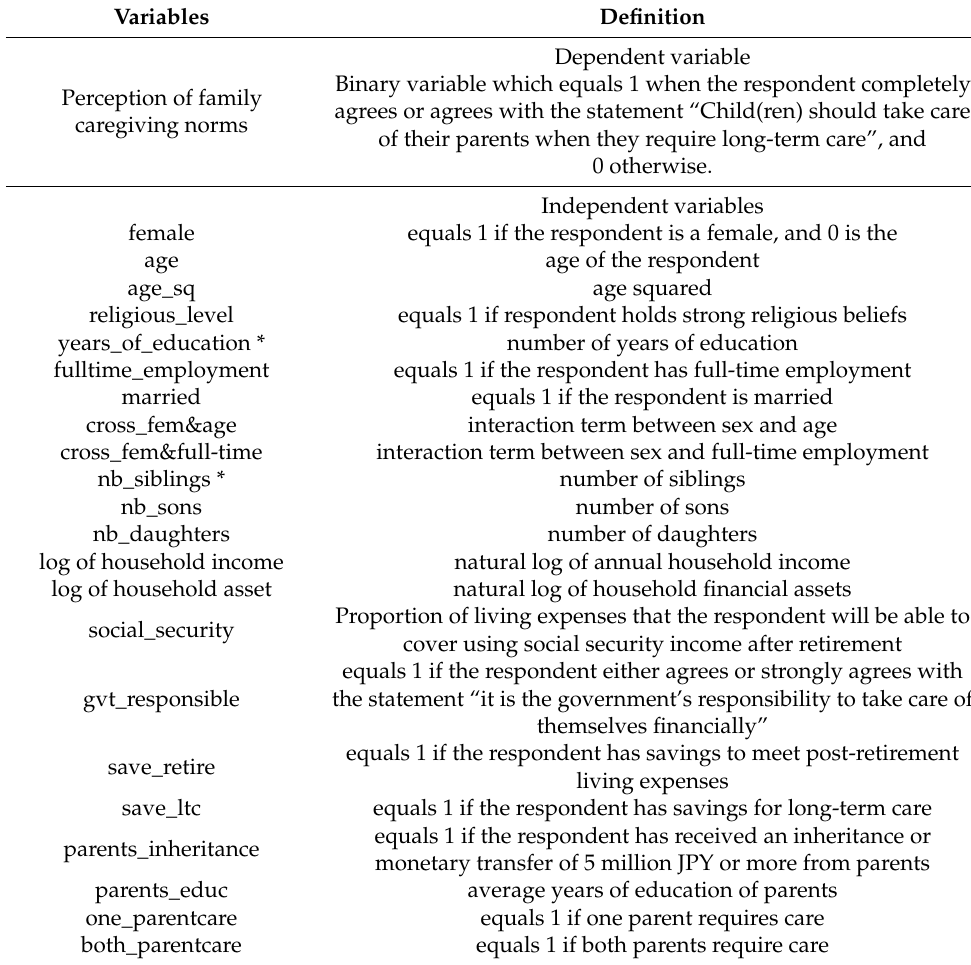
Table 1. Variable